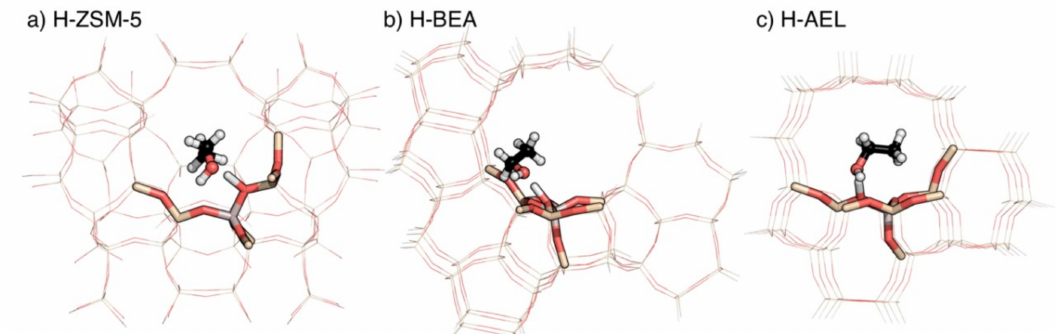
Figure 3. Systems studied for ethanol within ( a ) H-ZSM-5, ( b ) H-BEA, and ( c ) H-AEL. The ONIOM high-level DFT (Density Functional Theory) region is shown in “sticks”; the semi-empirical low level is shown in wireframe; and ethanol is shown as “ball and sticks.” The zeolite models used for isopropanol (IPA) and tert-amyl alcohol (TAA) were identical; (black: C atom; white: H atom; red: O atom; brown: Si atom; gray: Al atom).